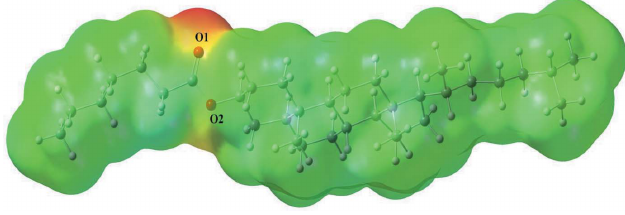
Table 3. The significance of (cid:5) and (cid:7) is to evaluate both the reactivity and stability. The HOMO and LUMO energy levels